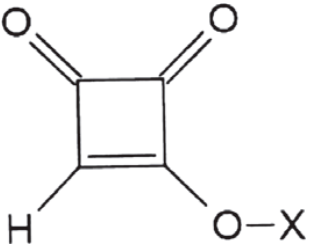
Figure 1. Chemical structure of moniliformin (X=H, Na, or K).